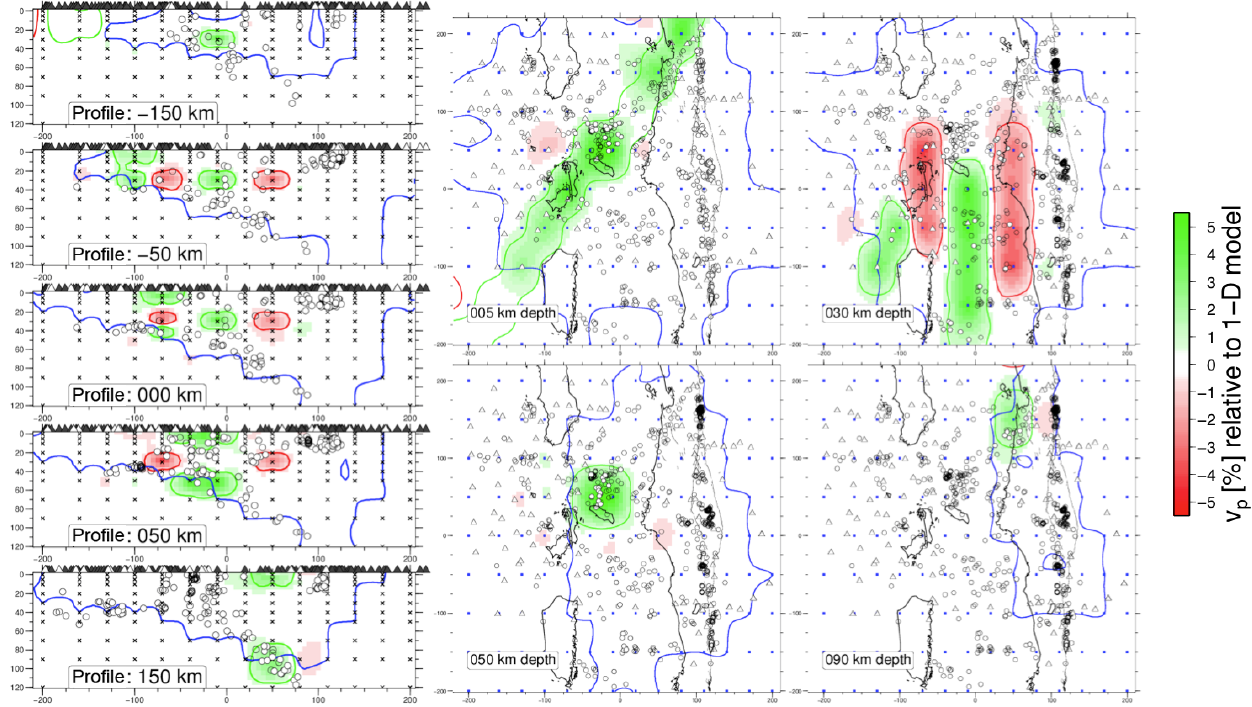
Figure 7. 3-D synthetic models with 5% velocity v p perturbation input anomalies and the inversion restoration. The model consists of north– south trending anomalies (map view 30km depth) and a NE–SW trending low velocity anomaly for both the shallow part of the model in 5km and for the trace of the subducted IFZ. Red and green lines indicate the 5% contour lines of the input anomalies. The blue lines encircle regions with good resolution defined by the spread value. Other symbols as in Fig.